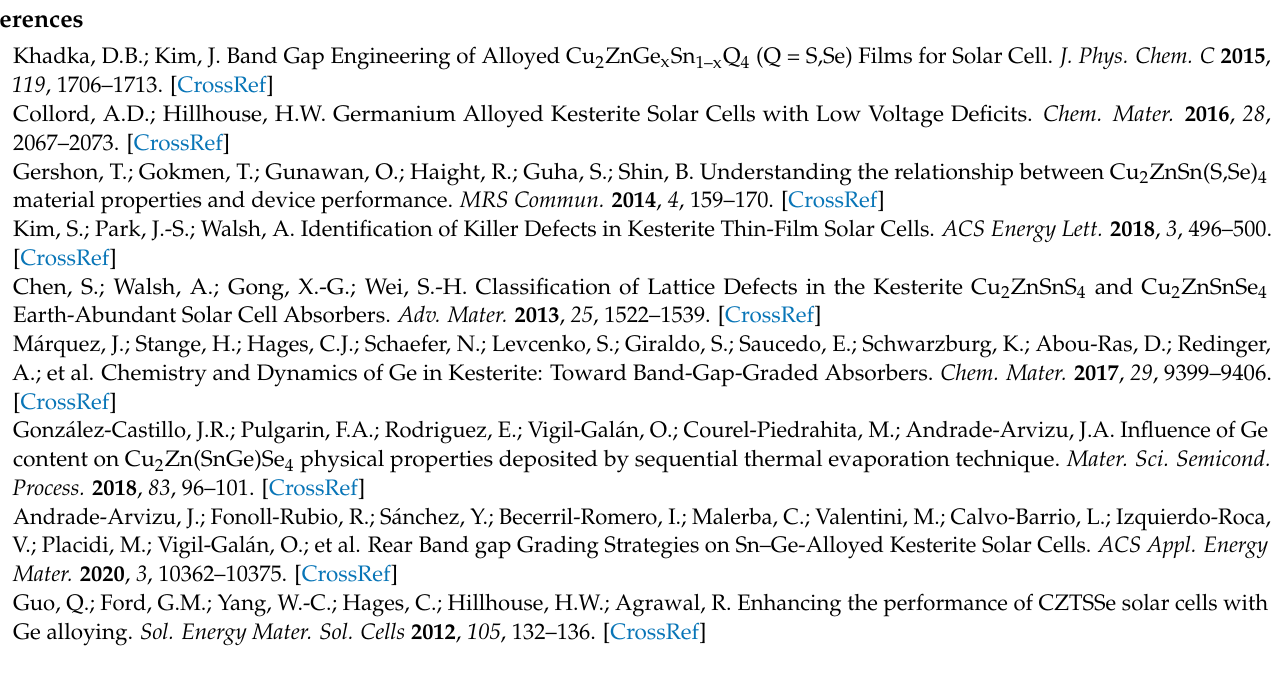
compounds.; Figure S2: Depth dependent EDX mapping of the samples.; Figure S3: Raman A1 peak position vs. Ge/(Ge + Sn) ratio for the samples; Figure S4: Cu/(Ge + Sn) ratio development for various samples.; Figure S5: X-ray diffractogram of the selected samples; Figure S6: PCE IV curves for sample with the best efficiency from this study.; Figure S7: IV curves of the Ge-incorporated